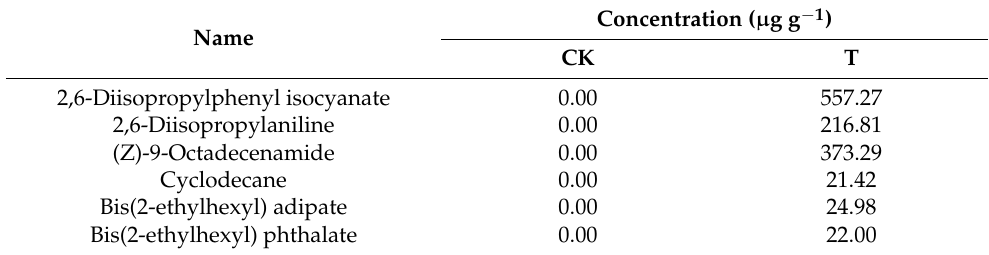
Table 1. Component analysis of PBAT-BMF